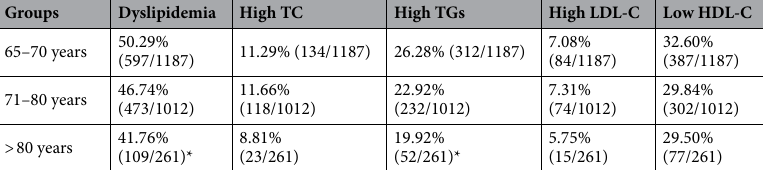
Table 3. Prevalence of dyslipidemia in three age groups (n = 2460). TC, total cholesterol; TGs, triglycerides; LDL-C, low density lipoprotein cholesterol; HDL-C, high density lipoprotein cholesterol. *The linear trend of dyslipidemia prevalence was examined by the Cochran-Armitage trend test. Compared with 65–70 years group and 71–80 years group, P value < 0.05 was considered statistical